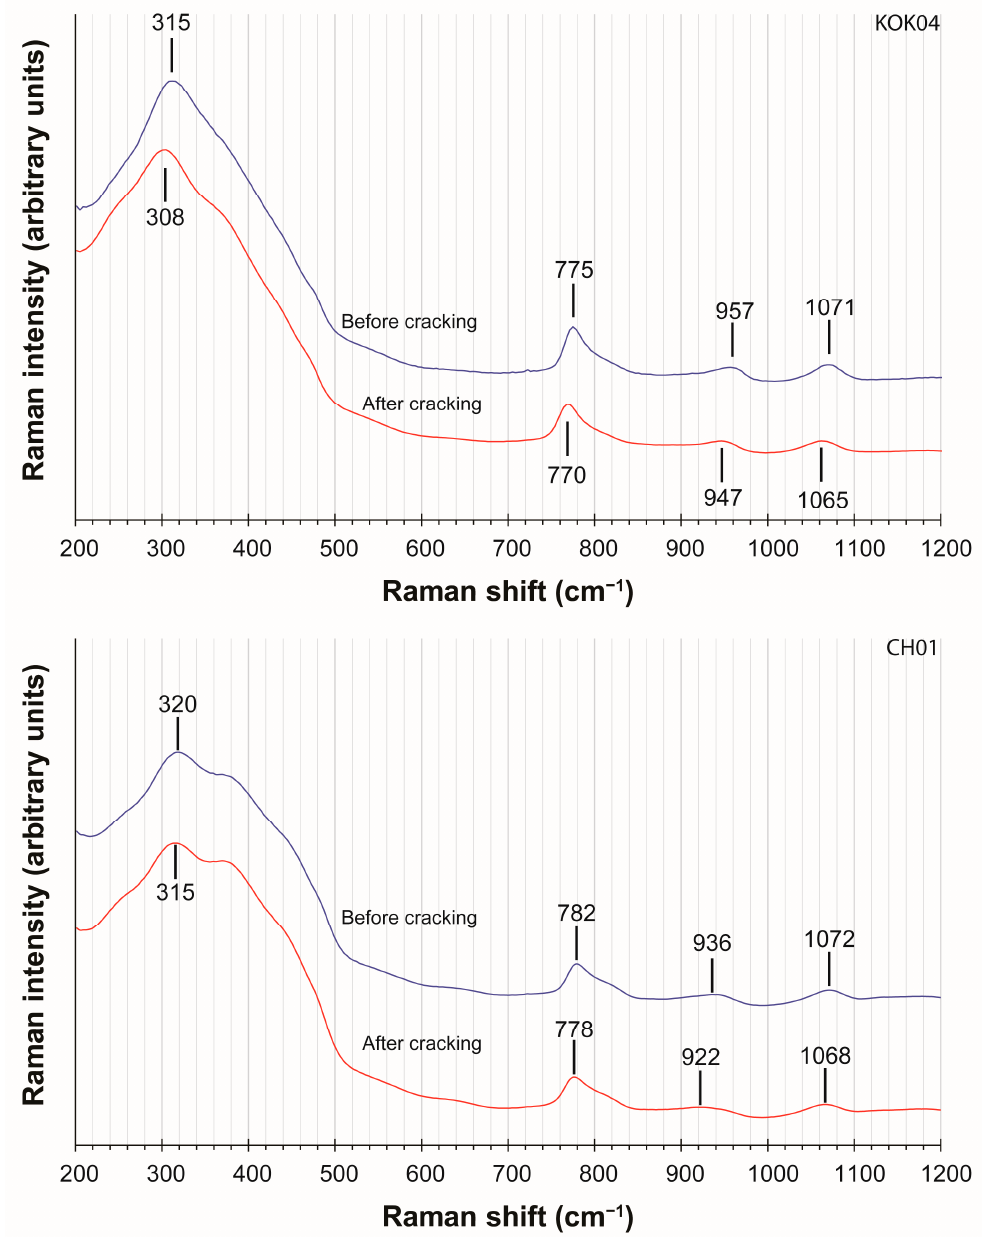
Figure 6. Representative Raman spectra before and after the cracking (blue and red, respectively) of water-stored samples KOK04 ( top ) and CH01 ( bottom ), displaying the shift in Raman bands toward low frequencies after the cracking of water-stored samples.